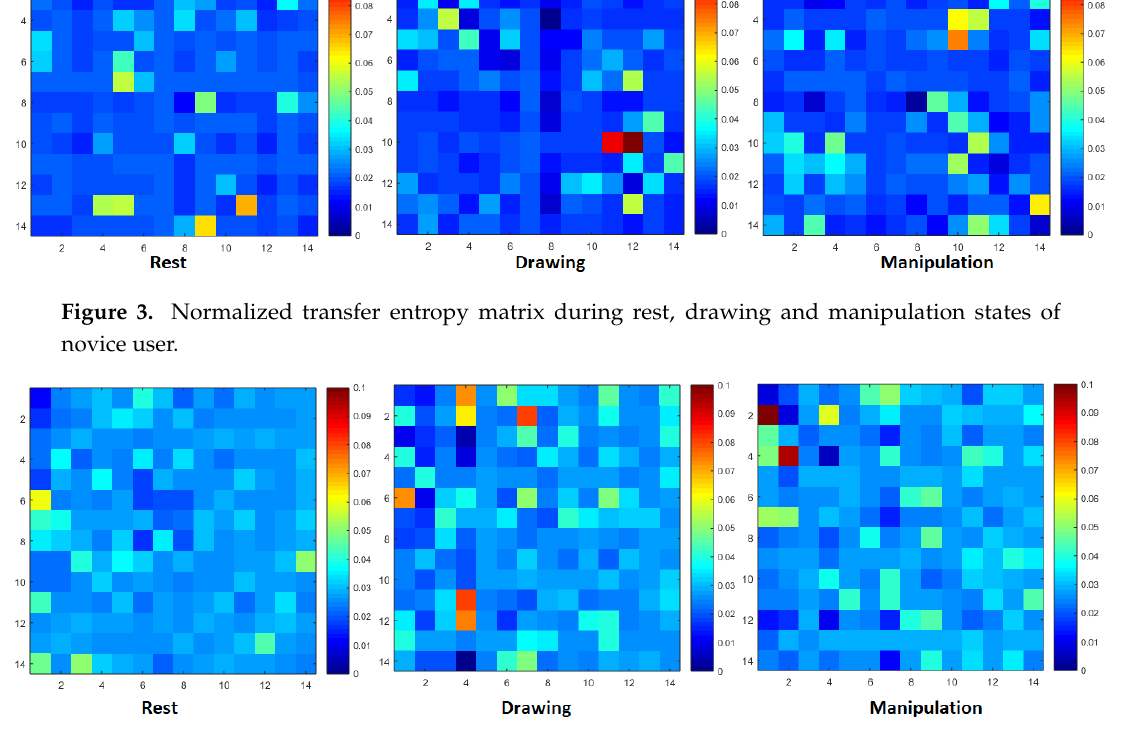
Figure 4. Normalized transfer entropy matrix during rest, drawing and manipulation states of expert